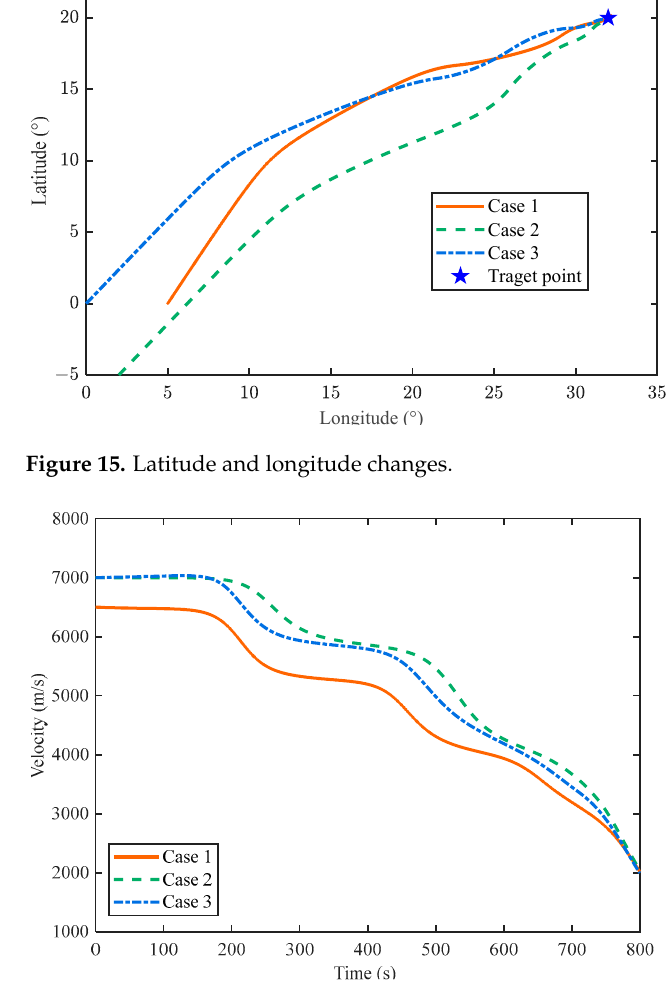
Figure 17. Time histories of the remaining voyage. Figure 18. Time histories of the path constraints. 0